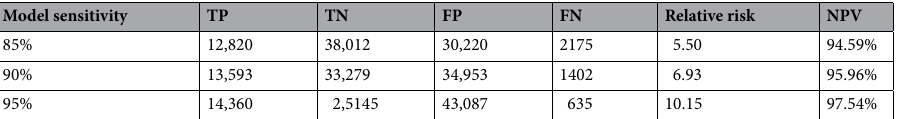
Table 3. The relative risks and negative predictive values delivered by the DT models with different levels of sensitivity. TP true positive, TN true negative, FP false positive, FN false negative, NPV negative predictive